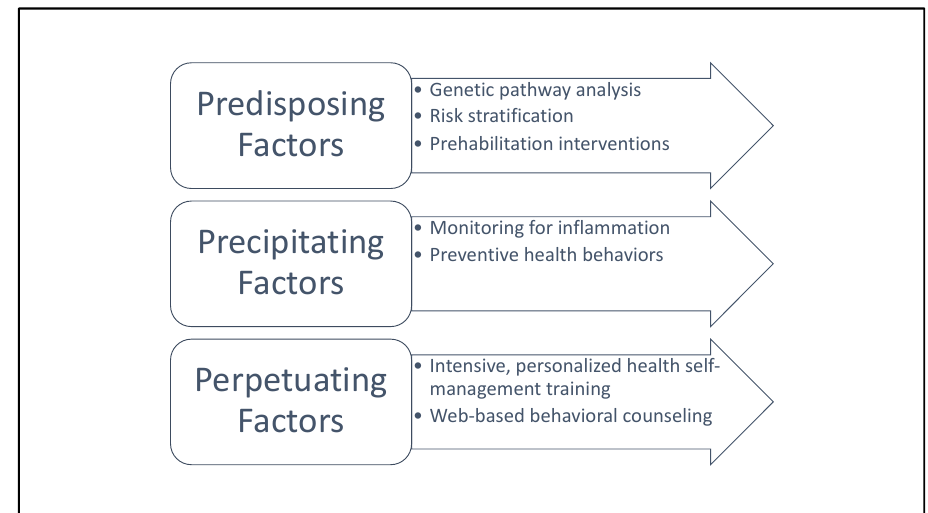
Figure 2. Recommended clinical actions to address each 3P factor.